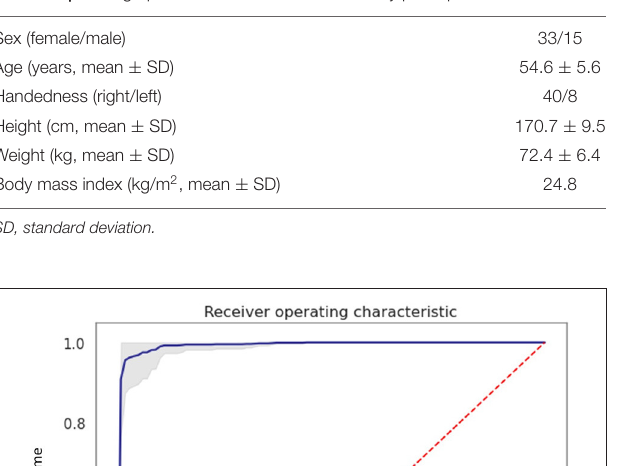
TABLE 1 | Demographic characteristics of the healthy participants.